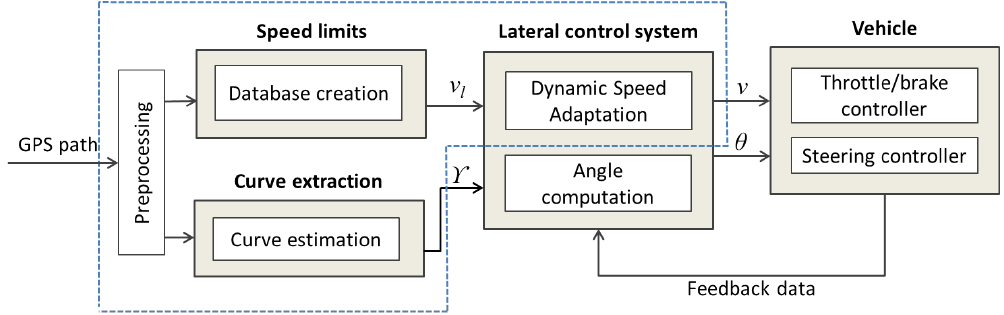
Figure 1. Overall workflow of the vehicle path tracking system. The blue dotted bounding box highlights our